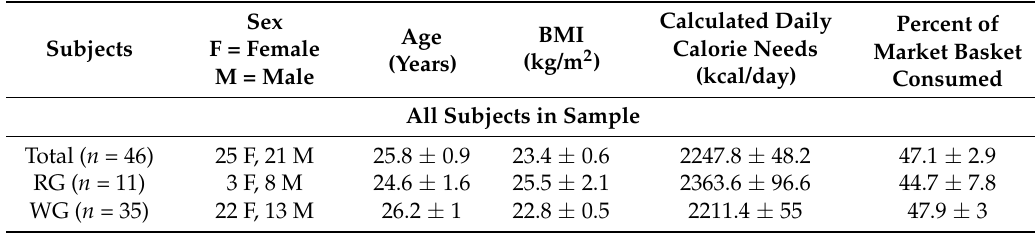
Table 2. Demographic information of subjects who received refined grain (RG) or whole grain (WG) market baskets 1